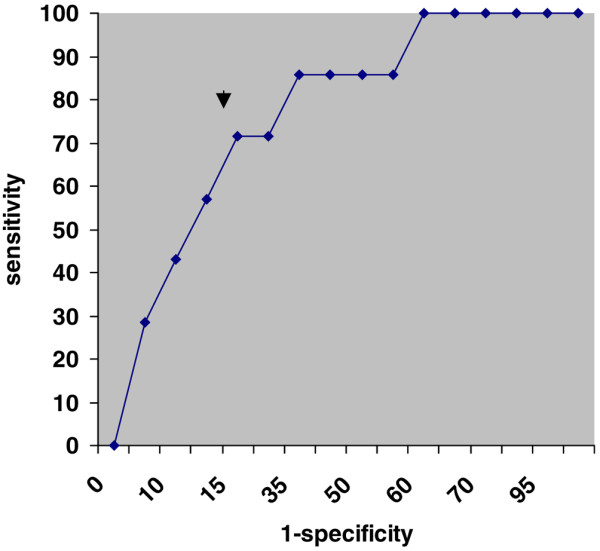
Receiver operator characteristic curve for continuous veno-venous hemofiltration (CVVH) duration. A receiver operating characteristic curve was used to assess the best cutoff for time to hemofiltration-filter clotting to predict a positive PF4 test. The arrow shows that a 6-hour duration of CVVH session is the most accurate cutoff (sensitivity 71%, specificity 85%, and area under the curve 0.83).